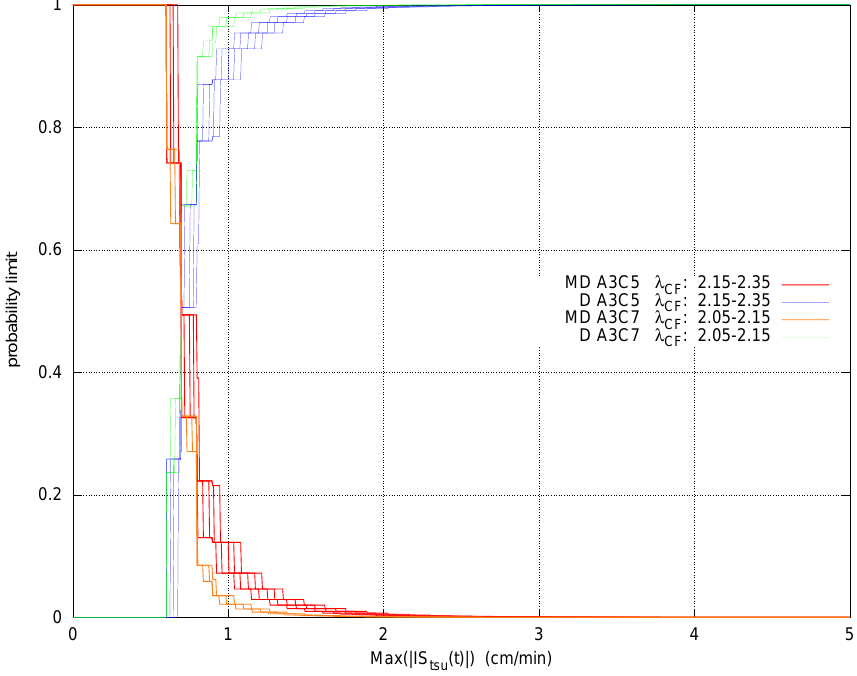
Fig. 10. Lower limit of probability for missed tsunami detection (red and orange) and upper limit of probability for tsunami detection (blue and green) derived from cumulative distributions of BS for both configurations A3C5 and A3C7 and computed for λ CF values taken from the intervals DTR A3C5 (5) and DTR A3C7 (5).